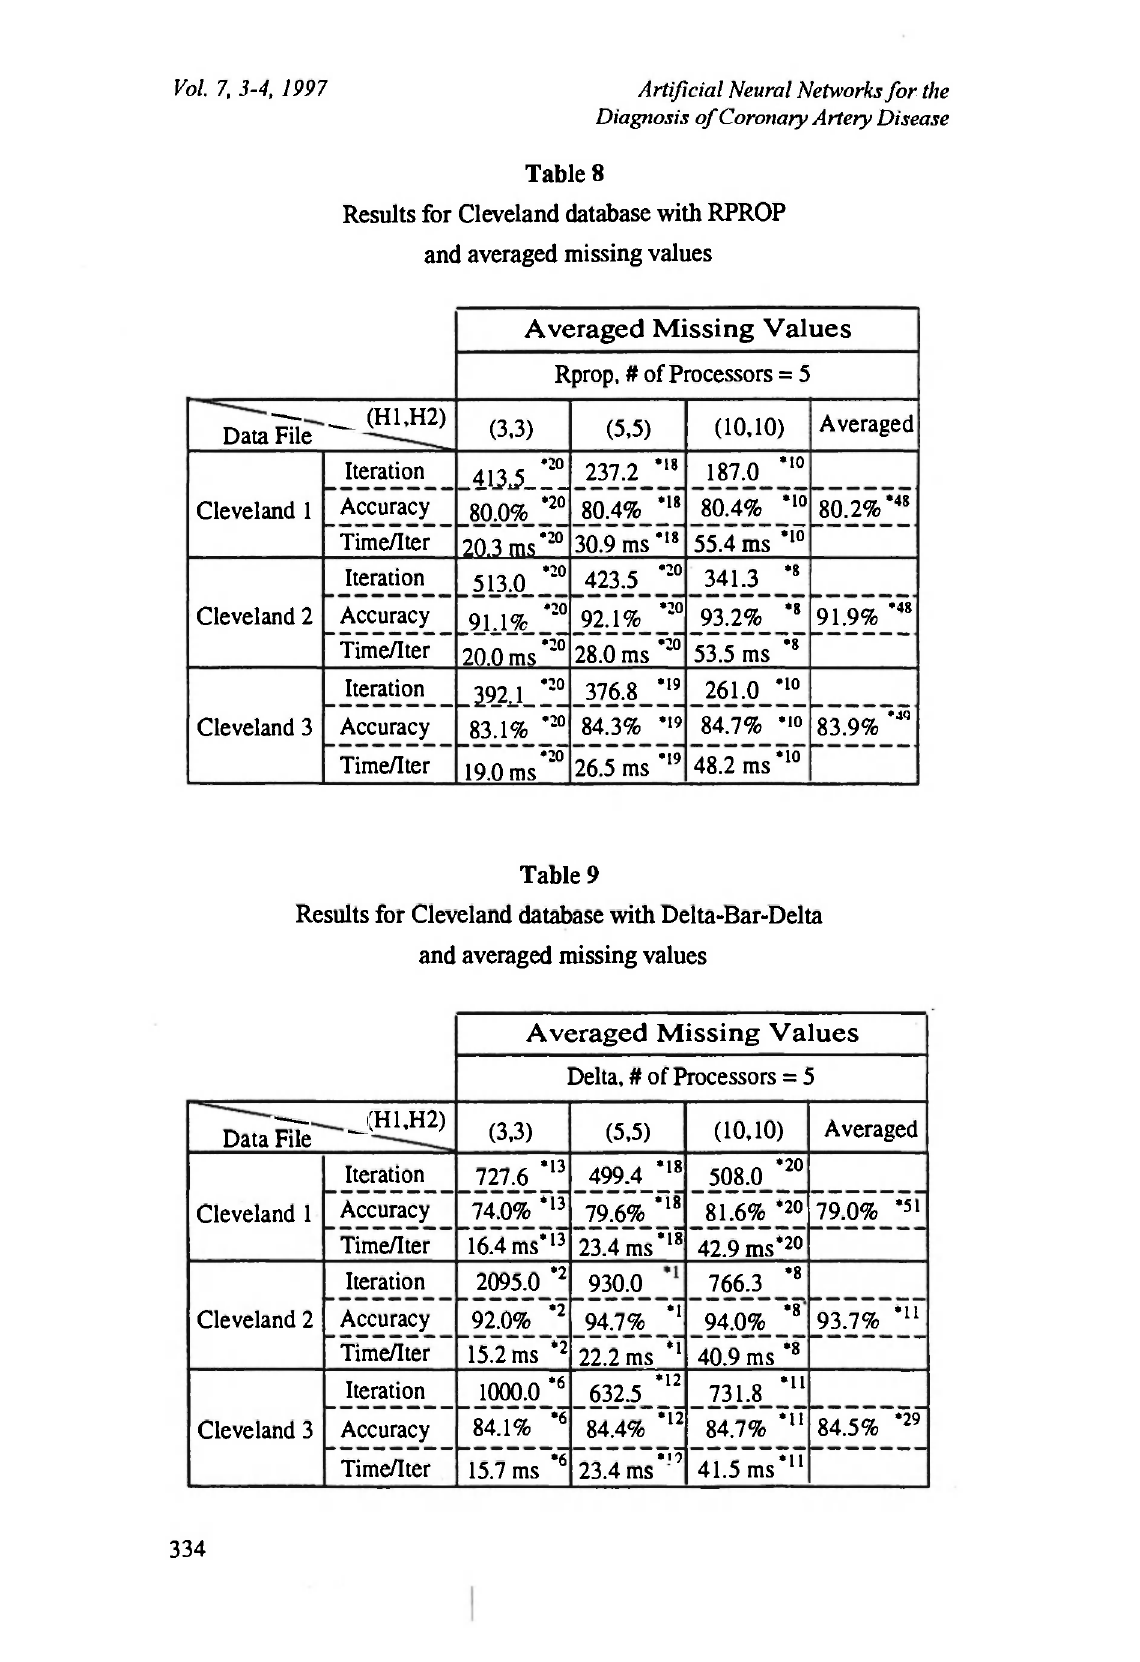
Results for Cleveland database with RPROP and averaged missing values Averaged Missing Values